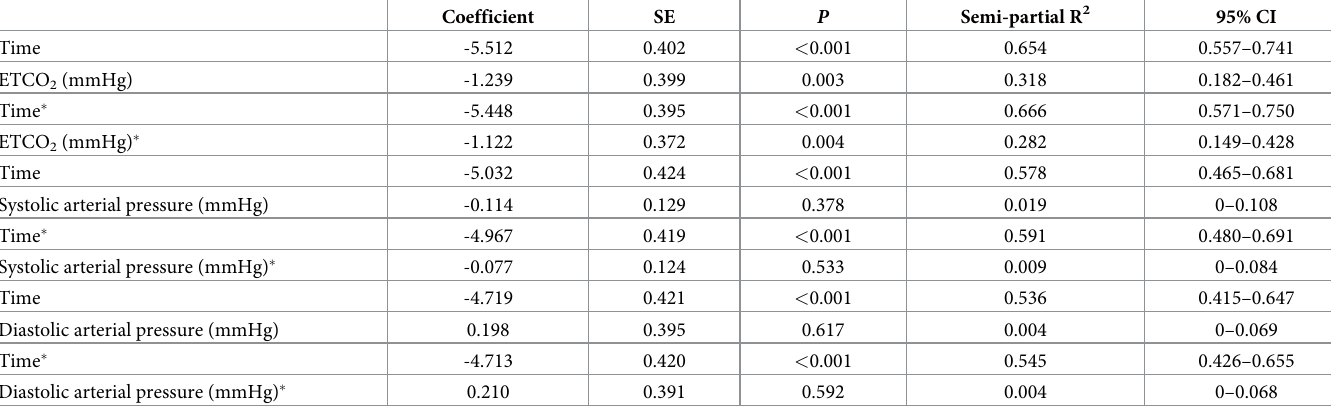
Table 4. Fixed effects of time and hemodynamic parameters on %EDV in mixed effect